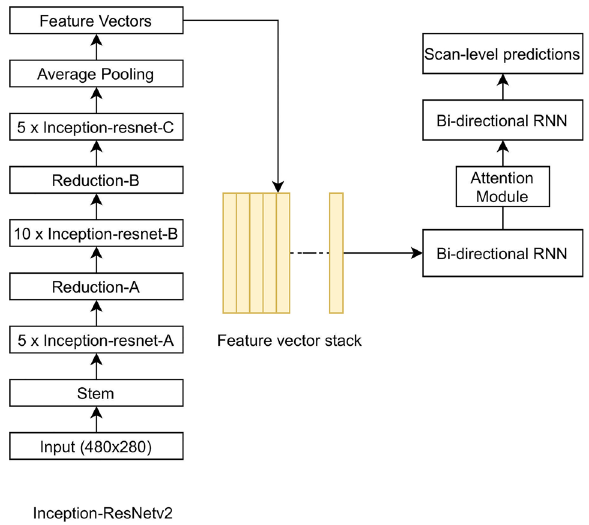
Figure 2. A diagram showing the joint convolutional neural network (CNN)-recurrent neural network (RNN) with an attention mechanism (The image was created by the authors using Microsoft PowerPoint v16). We used InceptionResNetV2 as the feature extractor with its top predictions layer removed. The extracted features were stacked per scan and fed into the bi-directional RNN. We placed an attention layer between two layers of the RNN, which facilitates RNN to focus on the most relevant slices to identify ICH and its